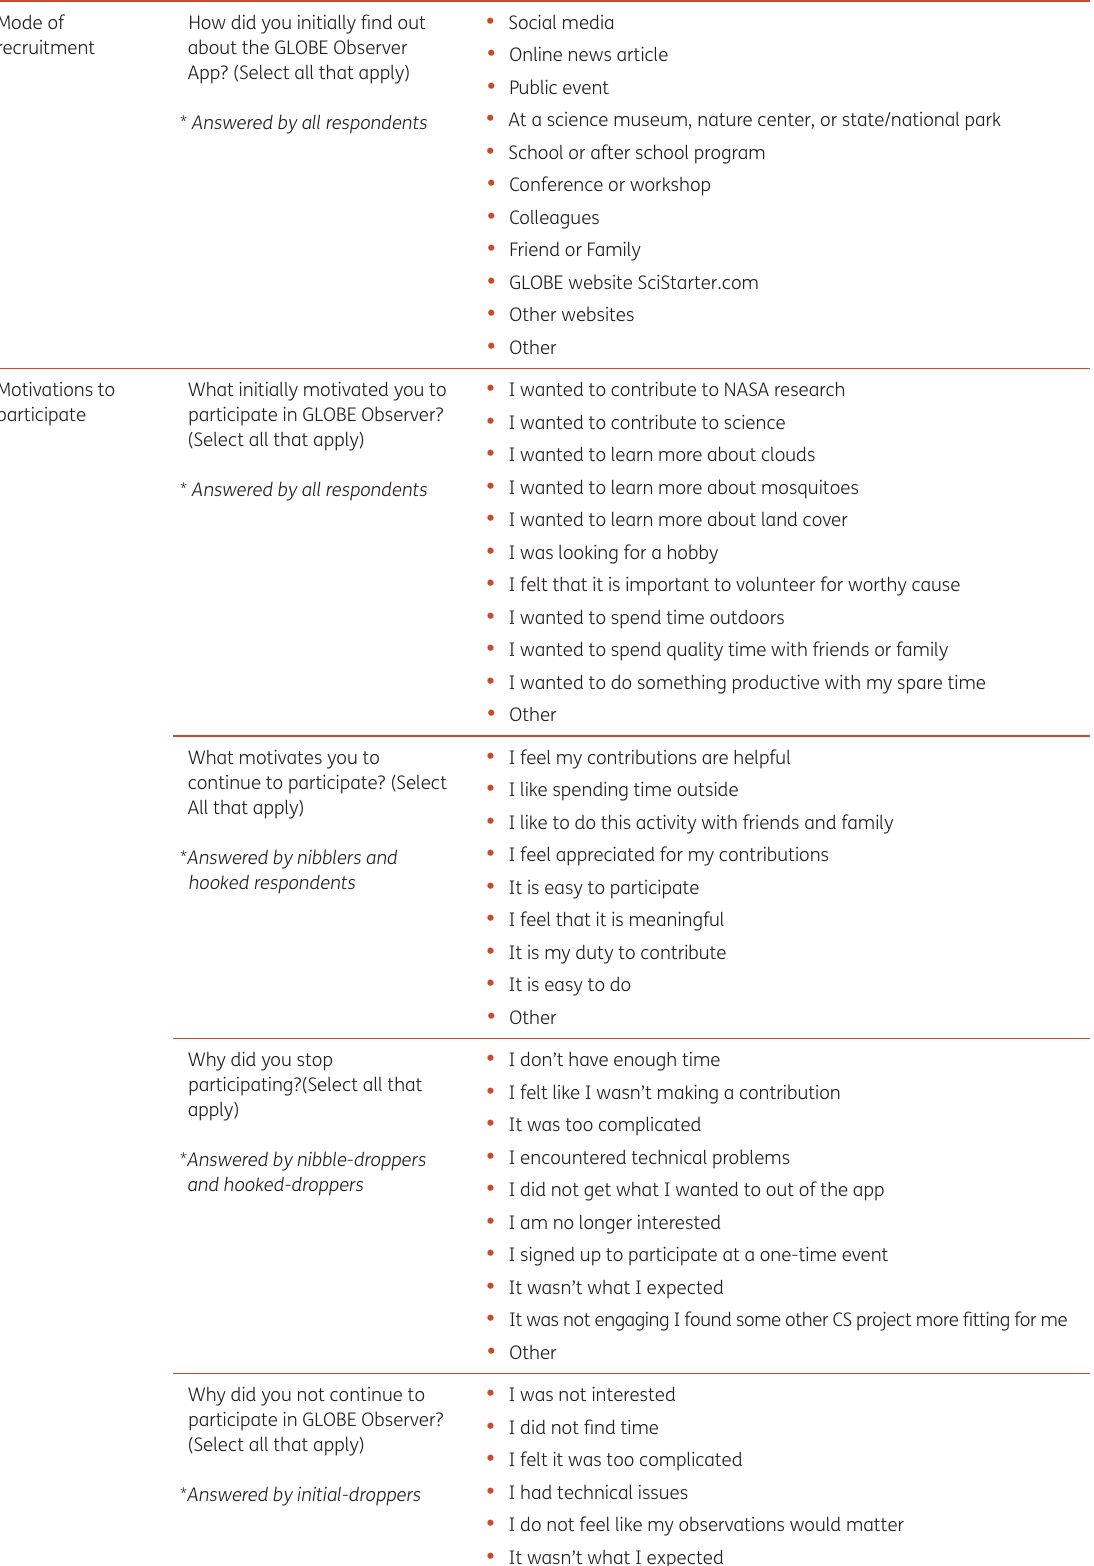
Table 1 Survey question